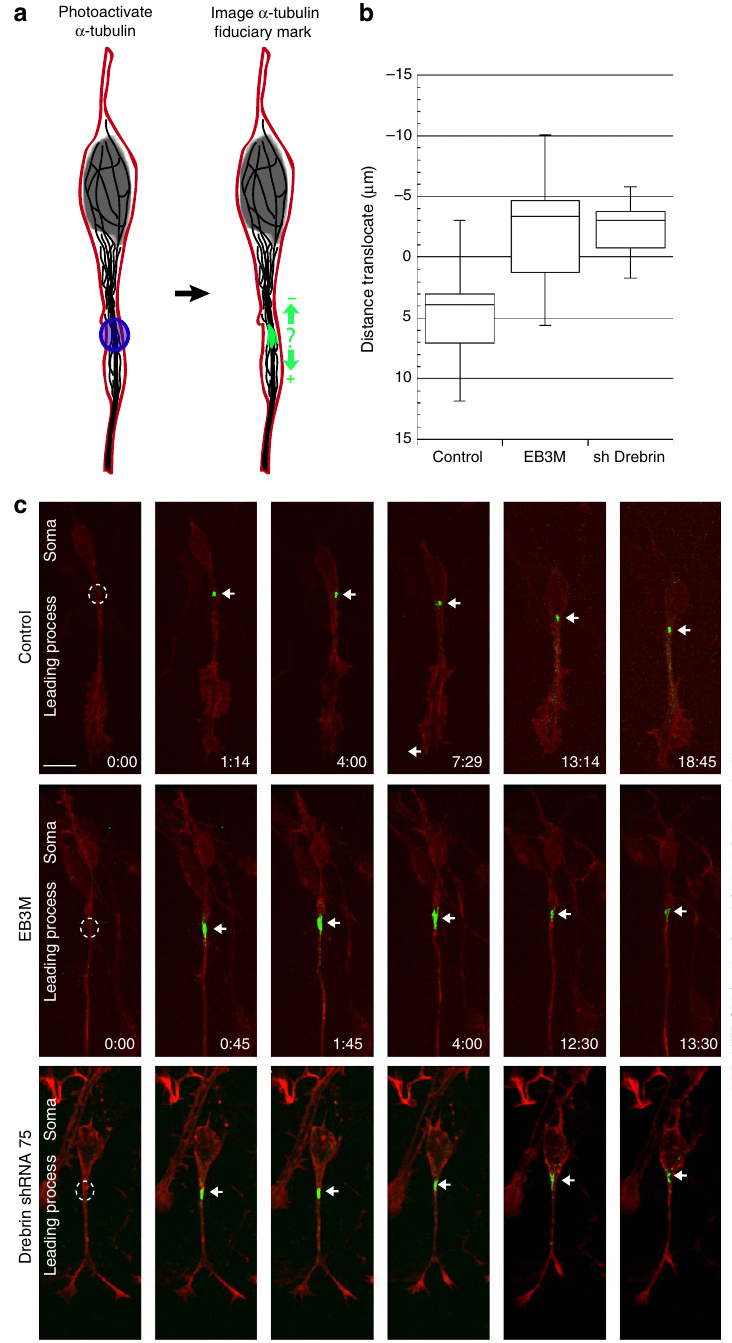
Figure 6 | Drebrin–microtubule interactions are required for proximal leading process microtubule movement in vitro . CGNs were transfected with expression vectors encoding photoactivatable EGFP- a -tubulin (green), RFP-UTRCH-ABD (f-actin label, red), or the indicated EB3M and drebrin shRNA constructs. ( a ) Schematic of the photoactivation strategy: a 405-nm laser was used to activate a microtubule fiduciary mark within well-dilated CGN proximal leading processes, and time-lapse imaging was used to monitor fiduciary mark movement during two-stroke nucleokinesis. Movements with positive values were towards the distal tip of the leading process (that is, in the direction of migration), whereas negative movement values were towards the cell body. ( b ) Box plot showing the average advance of the fiduciary mark in control, EB3M-expressing or drebrin -silenced CGNs. Control marks moved in the direction of migration, whereas the marks in EB3M-expressing cells retreated towards the soma ( n ¼ 15 for control, 27 for EB3M-expressing and 15 for drebrin- silenced cells, P o 0.01 for average advance by Student’s t -test). ( c ) Representative time-lapse frames for each condition: the soma is oriented at the top of each frame, with the leading process oriented down. A circle shows the site of photoactivation, and an arrow highlights the centroid of the fiduciary mark in each frame. Scale bar, 5 m m ( c ). Whiskers on the box plot shows maximum and minimum data points, box borders show first and third quartiles and the line in the box show the